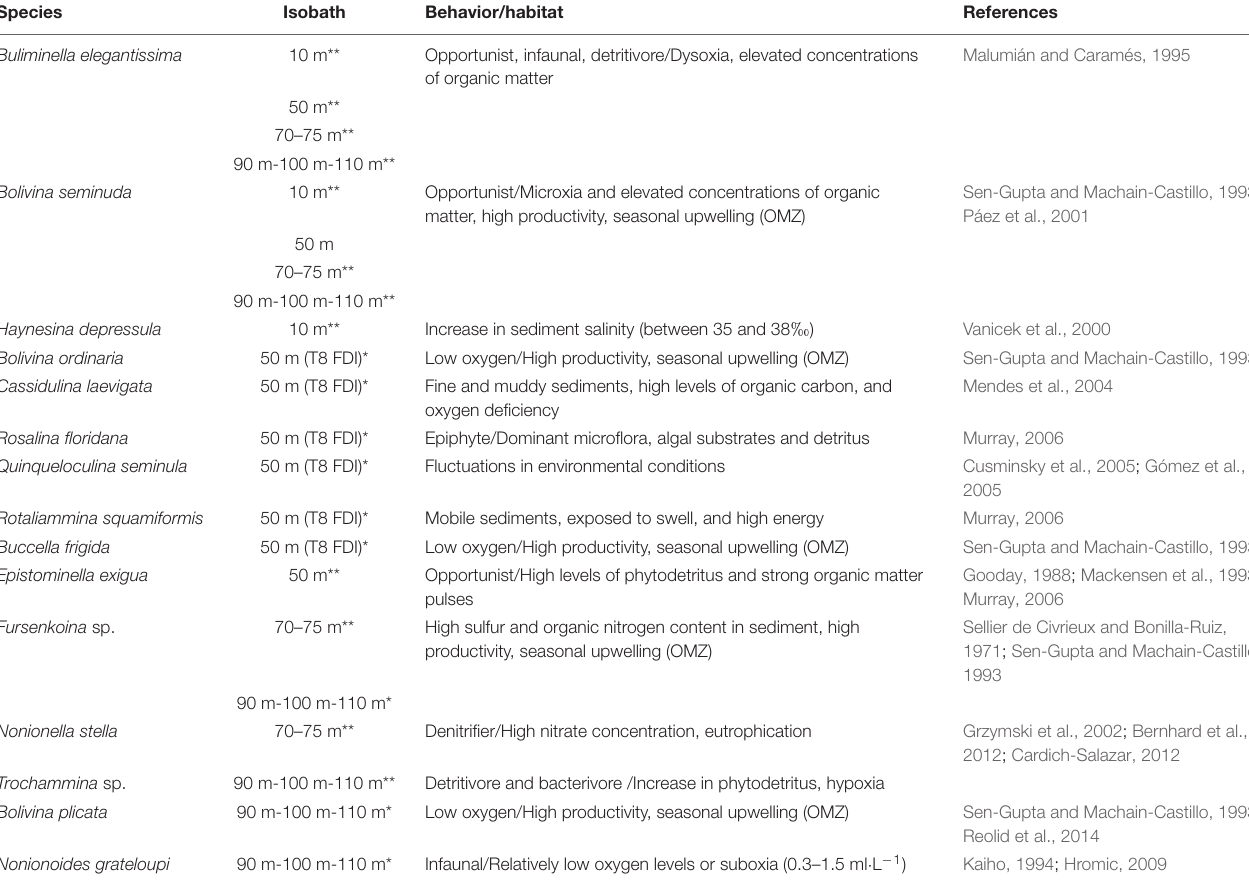
TABLE 2 | Behavior and habitat of the most representative species on the spatial distribution.